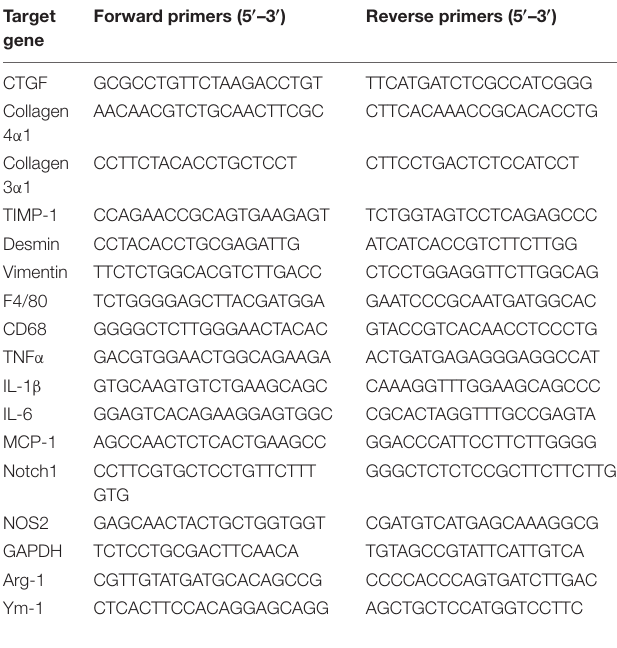
TABLE 1 | Mouse primer sequences used for quantitative RT-PCR. Target